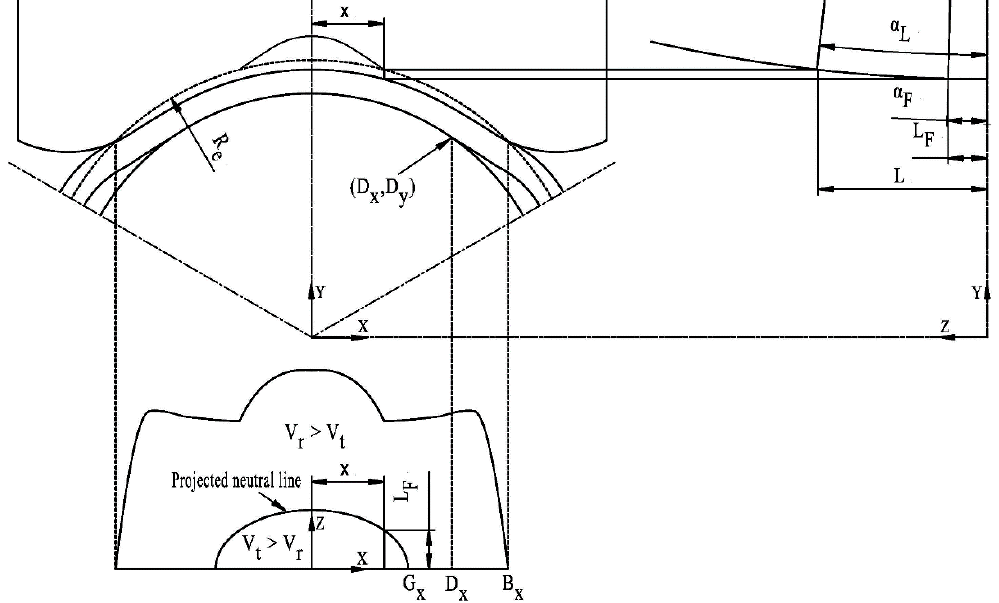
Figure 5. Geometrical relationship on the contact arc where both the metal forward slip and the metal backward slip exist.